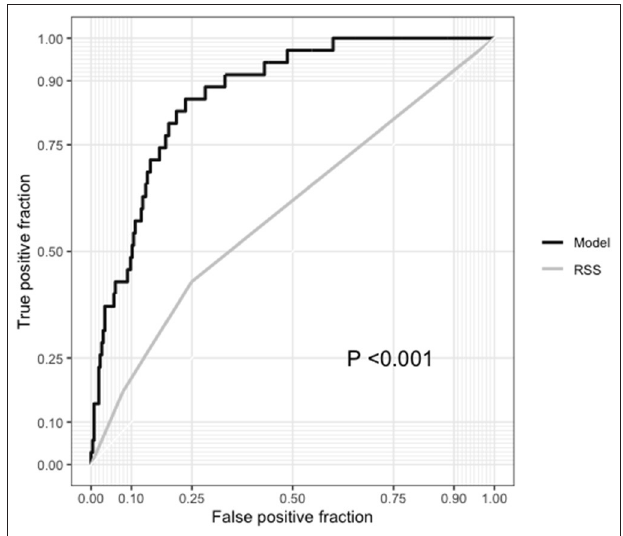
FIGURE 7 | Comparison between the receiver operating characteristic curves of our model and the residual SYNTAX score